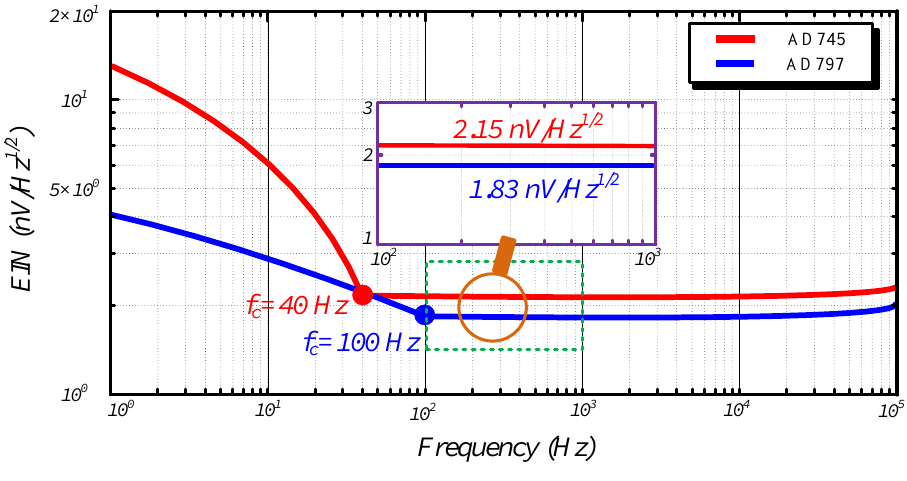
Figure 7. EINs of ACS calculated using AD797 and